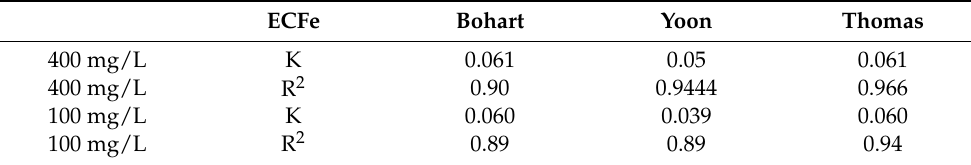
Table 9. Summary of the experiments obtained with ECFe